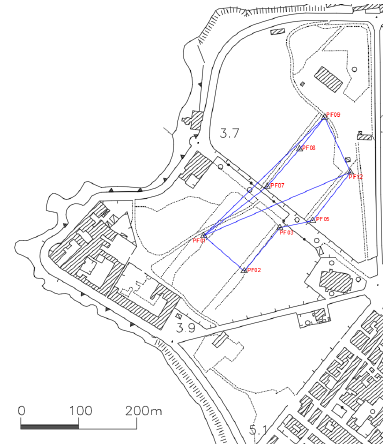
Figure 3. The topographic network.